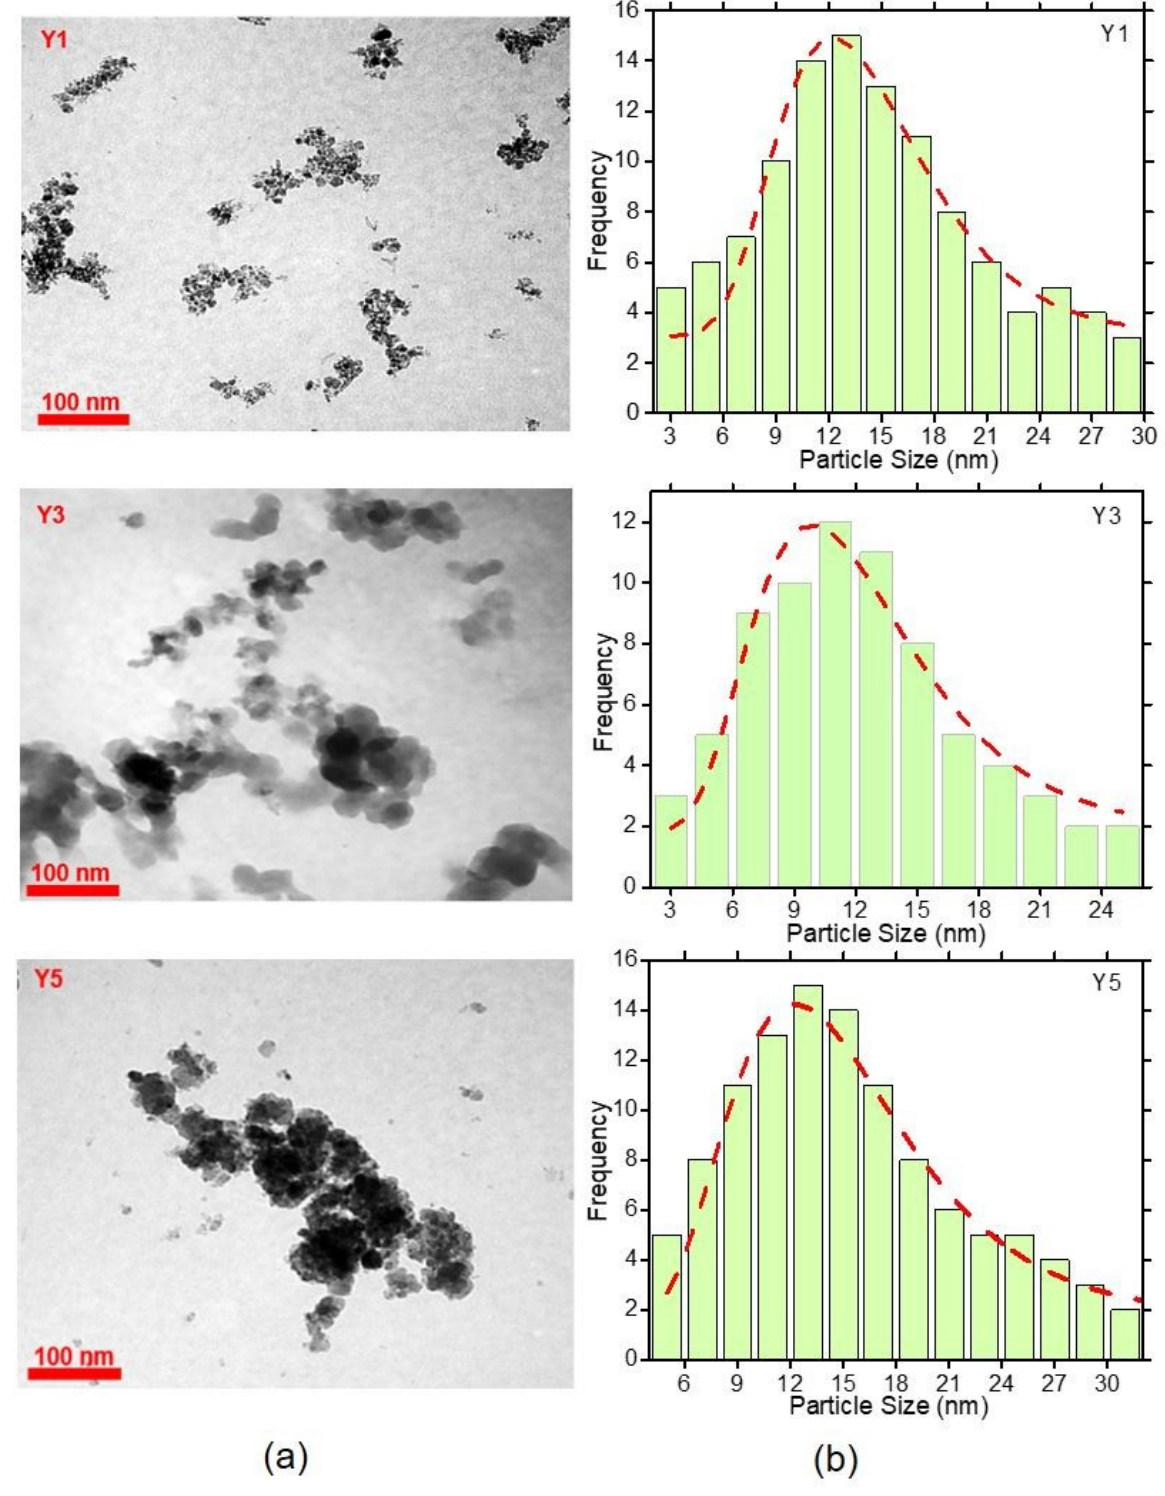
Figure 3. TEM images (a) and particle size distributions (b) of the dried Zn-doped magnetite